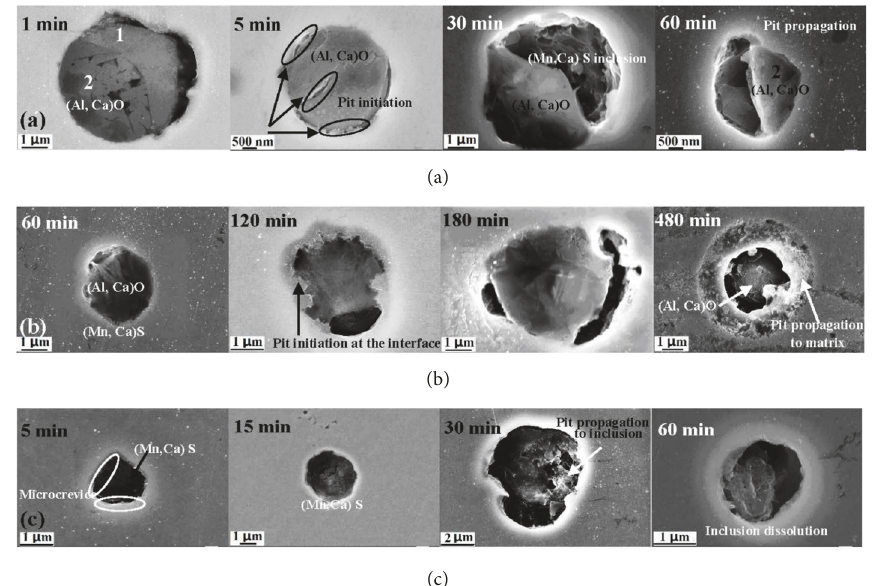
Figure 6: SEM images of three types of inclusions after initiation and propagation of pitting corrosion in X70 steel: (a) Type A (particles of (Al, Ca)O and (Mn,Ca)S); (b) Type B ((Al,Ca)O),and (c) Type C ((Mn, Ca)S). Steel was immersed in 0.1mol/L NaCl and 0.5mol/L NaHCO 3 solutions at 25 ∘ C for times indicated in figure